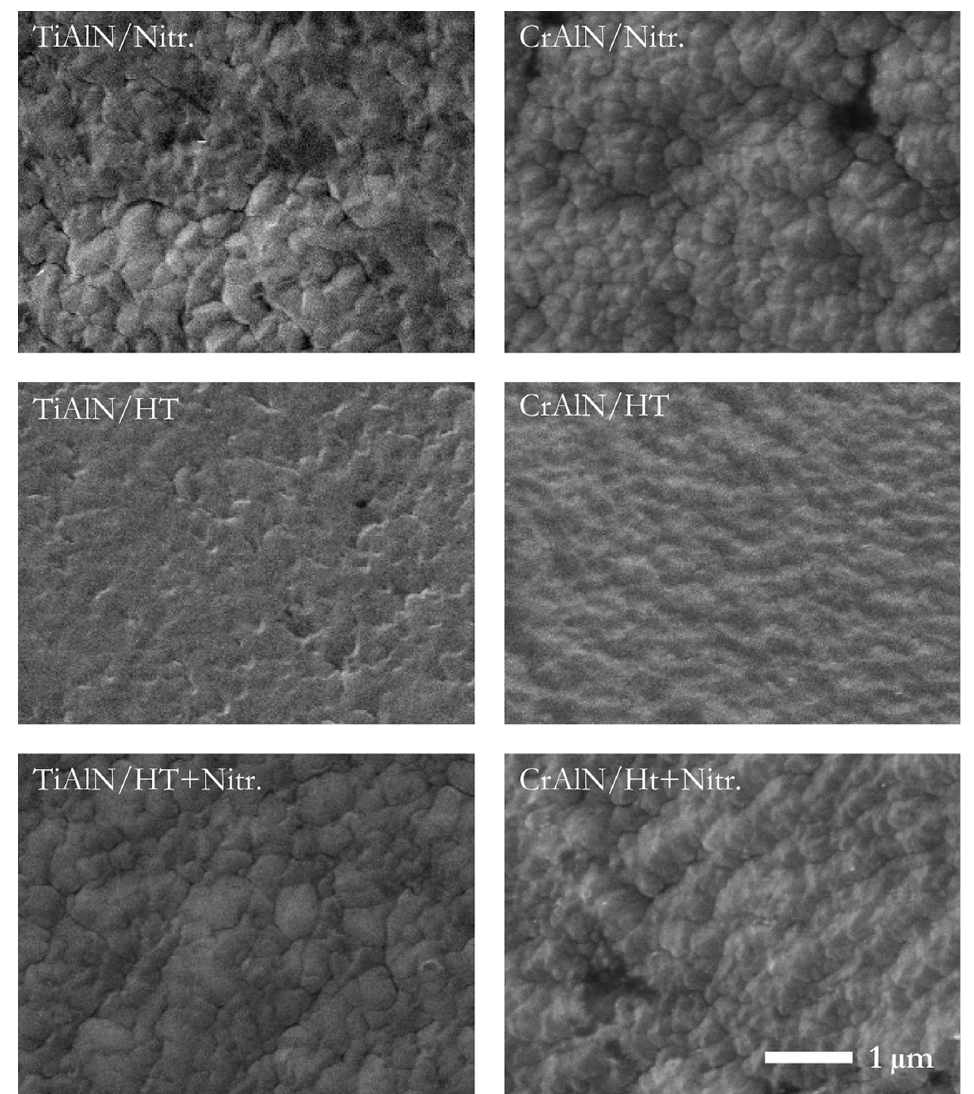
Figure 2. SEM micrographs of the topography of the TiAlN and CrAlN coatings deposited on the different substrates.